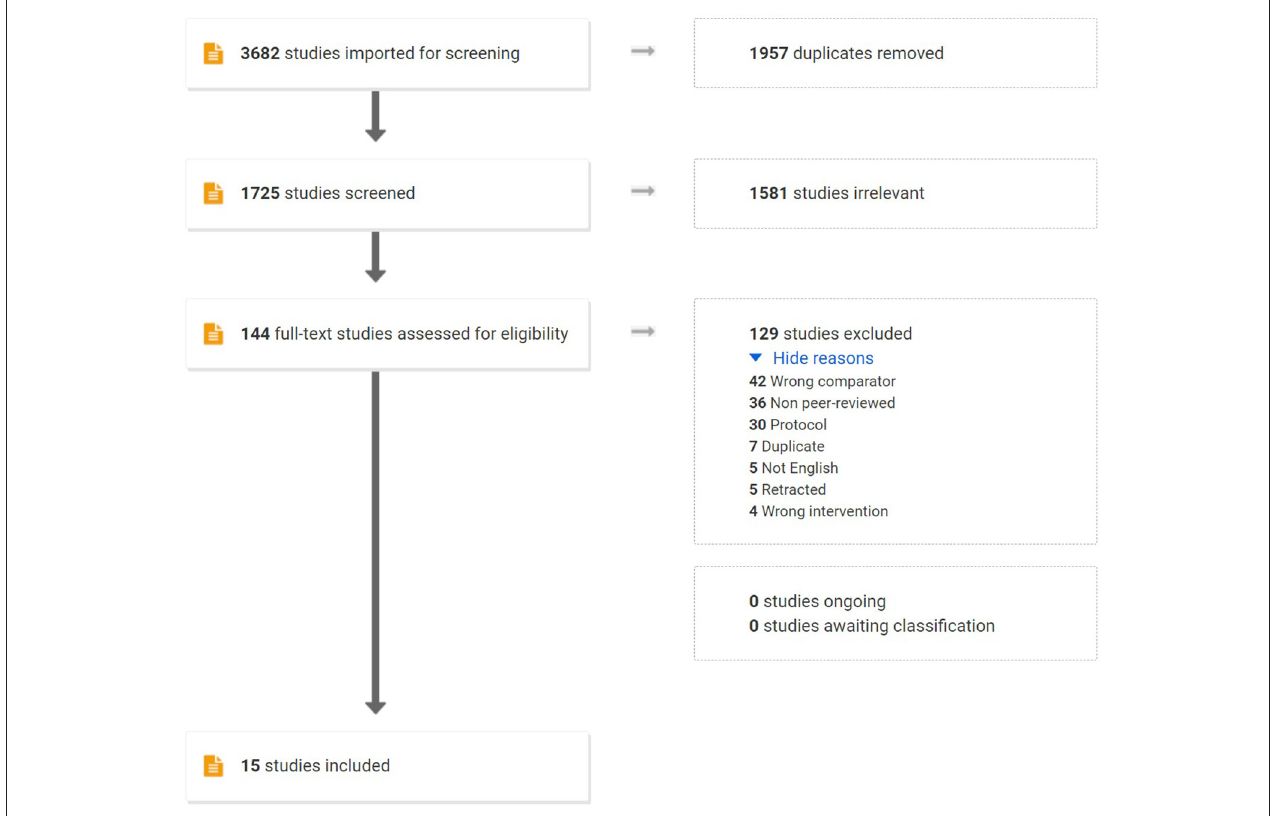
FIGURE 1 | Flowchart of this systematic review with meta-analysis of prospective studies. RCTs, randomized controlled trials.